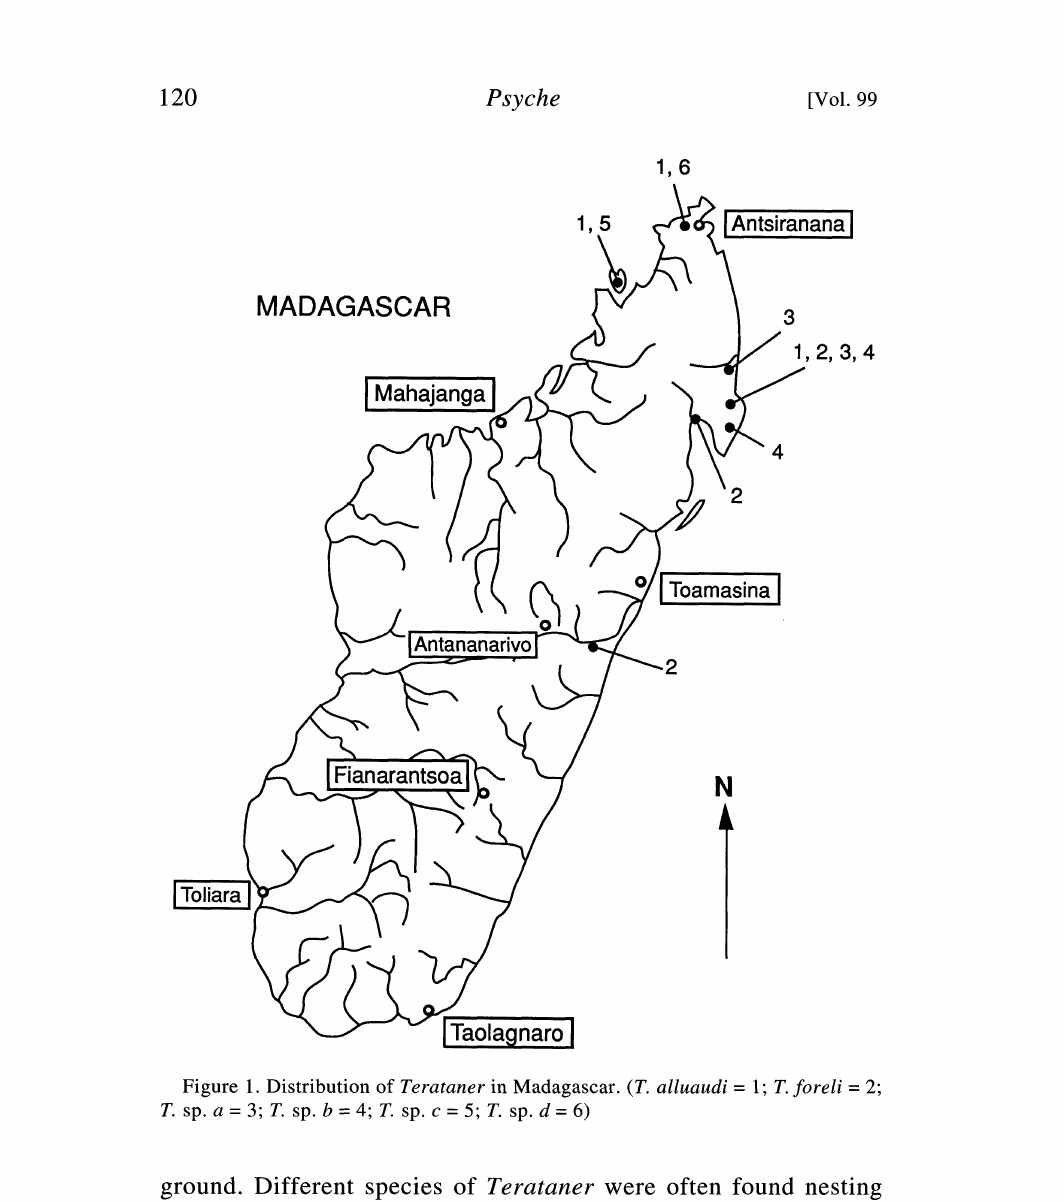
Figure 1. Distribution of Terataner in Madagascar. (T. alluaudi 1" T. foreli 2; T. sp.a= 3; T. sp. b 4" T. sp.c= 5; T. sp. d= 6) ground. Different species of Terataner were often found nesting within a meter of one another in the same habitat. T. alluaudi, a widespread species, was found sympatrically with T. foreli and the more restricted species T. sp. a, T. sp. b, T. sp. c, and T. sp. d. Lar- vae, pupae and adults were packed together into a central